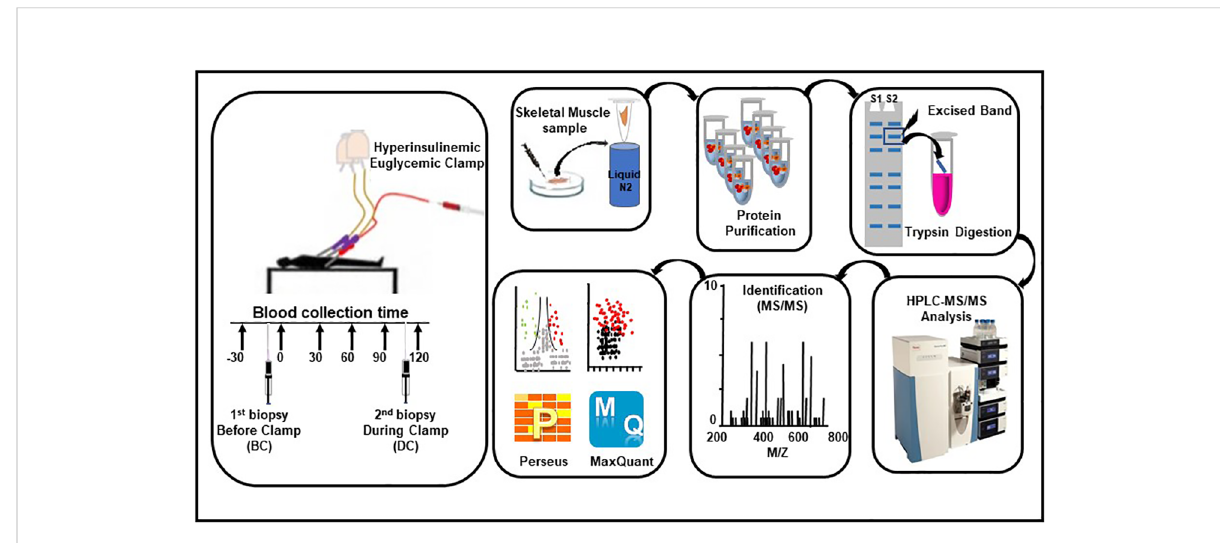
FIGURE 1 Work fl ow for the hyperinsulinemic euglycemic clamp, skeletal muscle biopsies, sample processing, and proteomic